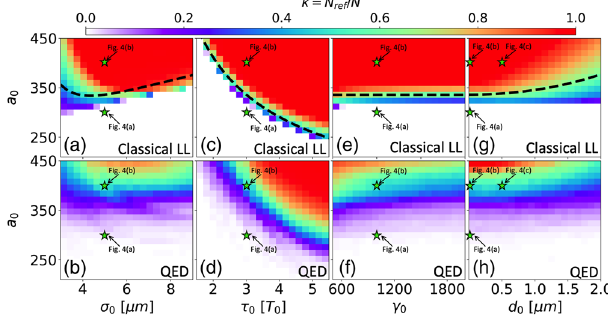
FIG. 3. (a),(b) The ratio κ obtained from 3D simulations figured in a 0 − σ 0 space for τ 0 ¼ 3 T 0 , γ 0 ¼ 1000 , and d 0 ¼ 0 μ m. (c),(d) and (e),(f) are identical with (a),(b), except the parameter planes are in τ 0 − a 0 (for σ 0 ¼ 5 μ m, γ 0 ¼ 1000 , and d 0 ¼ 0 μ m) and γ − a 5 μ m, τ 3 T 0 μ m), respectively. 0 0 (for r 0 ¼ 0 ¼ 0 , and d 0 ¼ (g),(h) exhibit the results in a 0 − d 0 space, where σ 0 ¼ 5 μ m, τ LL case denote the theoretical threshold of Eq. (11). The green pentagrams correspond to the parameters used in Figs. 4(a) – 4(c).